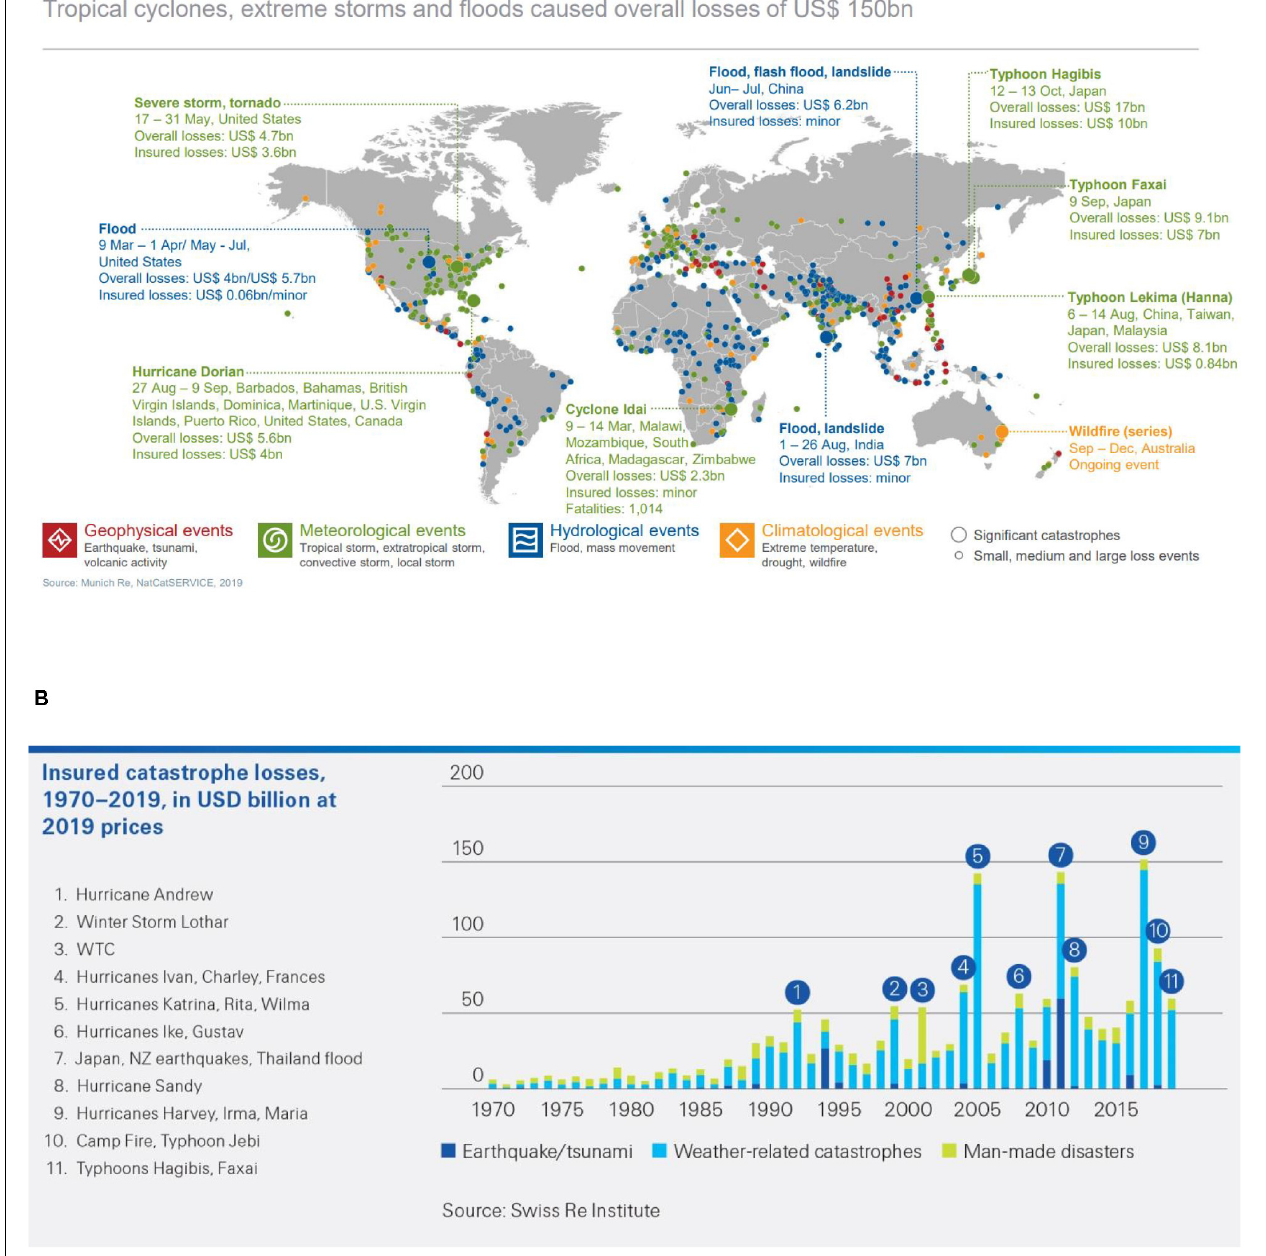
FIGURE 1 | Location of natural loss events as compiled by reinsurance companies. (A) Loss events worldwide in 2019 and (B) overall losses during 1980–2019, identifying the 10 costliest events during that period (bottom). N.b ., these compilations of natural losses do not include any harmful algal bloom events. Sources: (A) Munich Reinsurance Company [MunichRe] (2020) (2020 Münchener Rückversicherungs-Gesellschaft, NatCatSERVICE); (B) Swiss Re Institute (2020). Figures reprinted with permission.